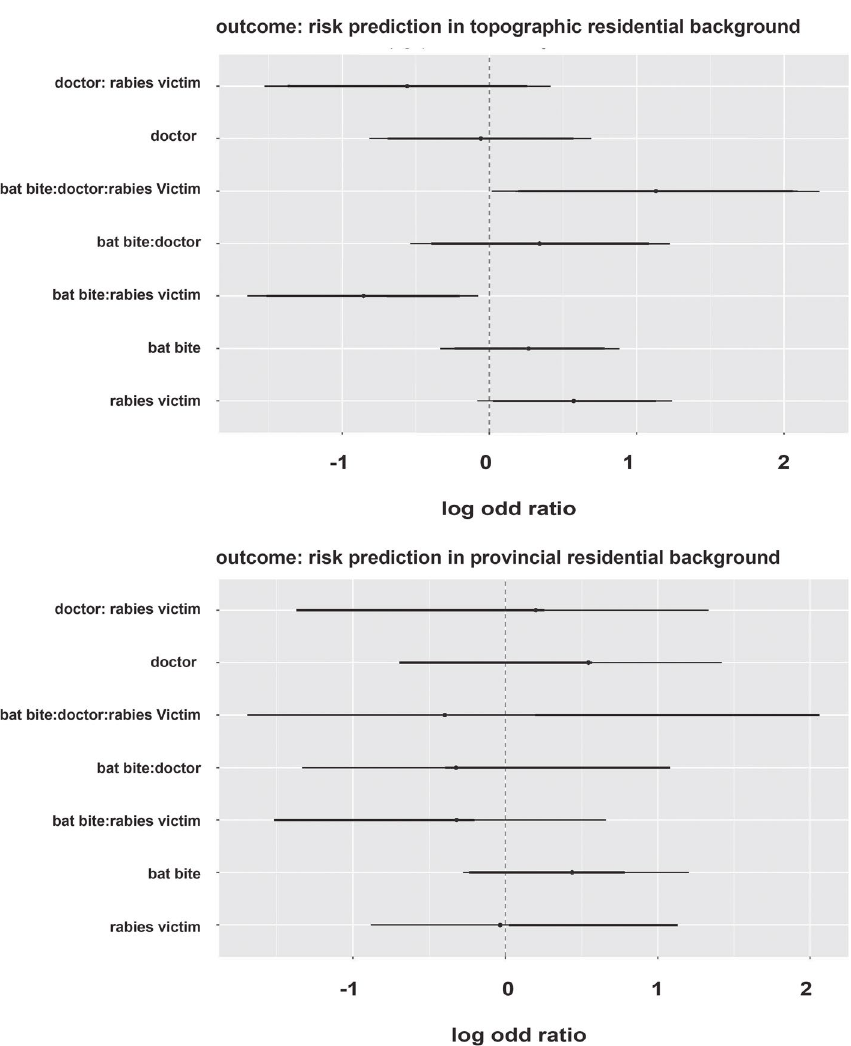
Fig. 3 Logistic regression model cofficients plots for risk prediction in bat human interacting in pakistan, A Cross-Sectional Survey on Fruit Bat-Human Interaction in Pakistan; One Health Perspective,